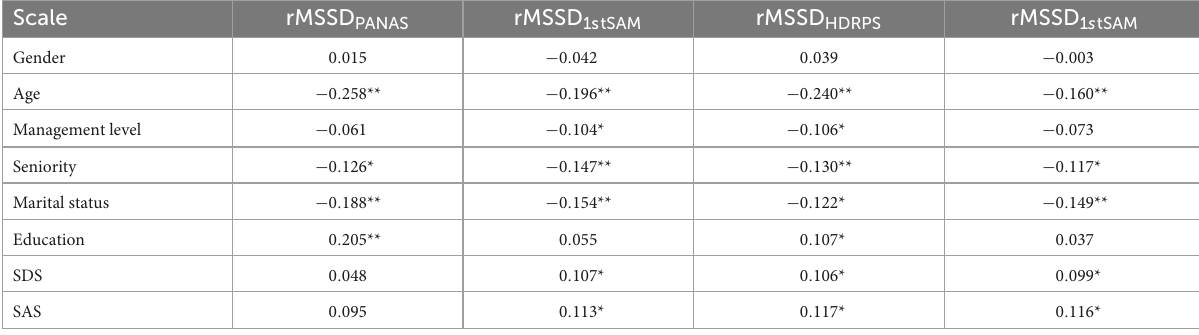
TABLE 6 Analysis of affective